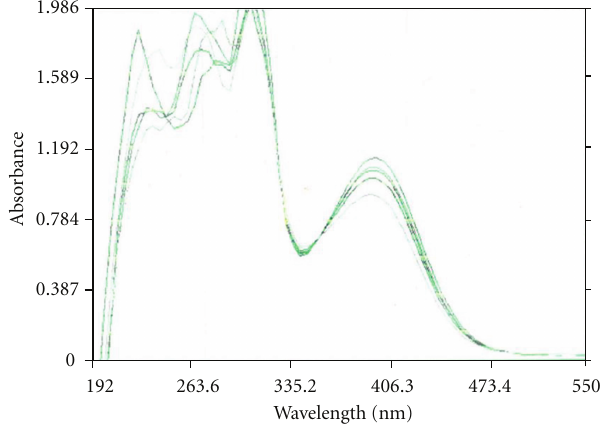
Figure 4: UV-Vis absorption Spectra of [Ni(1,10-phen)(EMIIMP) (H 2 O) 2 ]Cl (10 μ M) in the presence of increasing amounts of CT- DNA ; [DNA] = 0, 10, 20, 30, 40, 50 μ M.